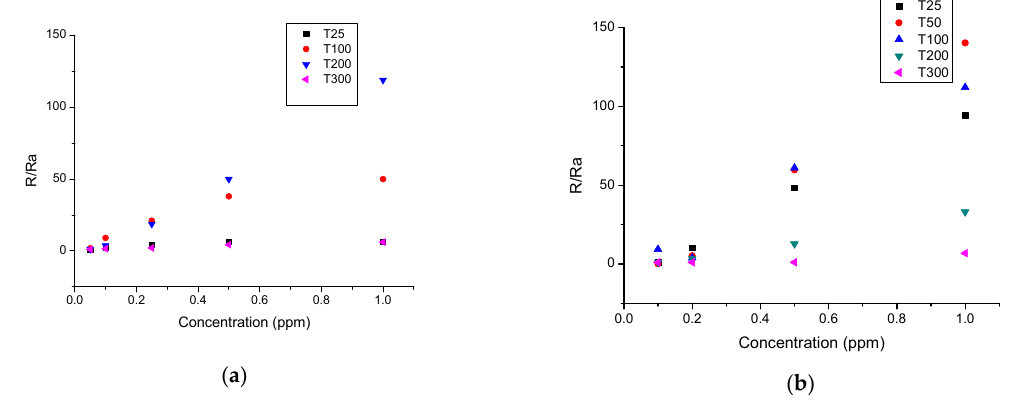
Figure 3. ( a ) Rresponse of the pure SnO 2 device at different temperatures; ( b ) response of the graphene (0.1 mg/mL) doped SnO 2 device at different